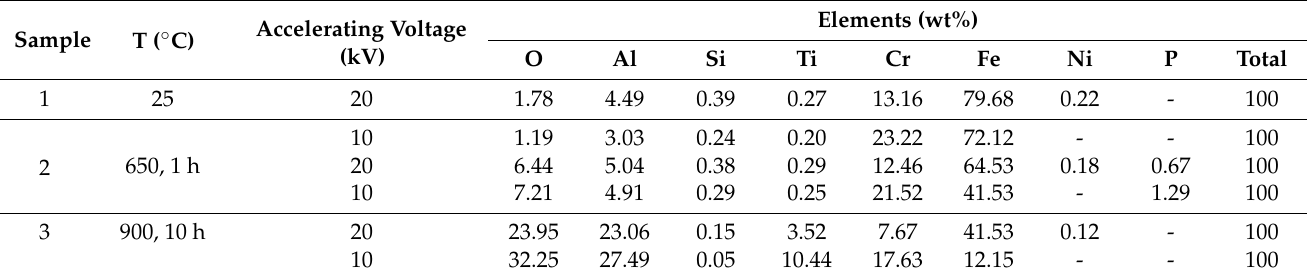
Table 1. Elemental composition of the Fe-Cr-Al foil surface in the initial state and after thermal